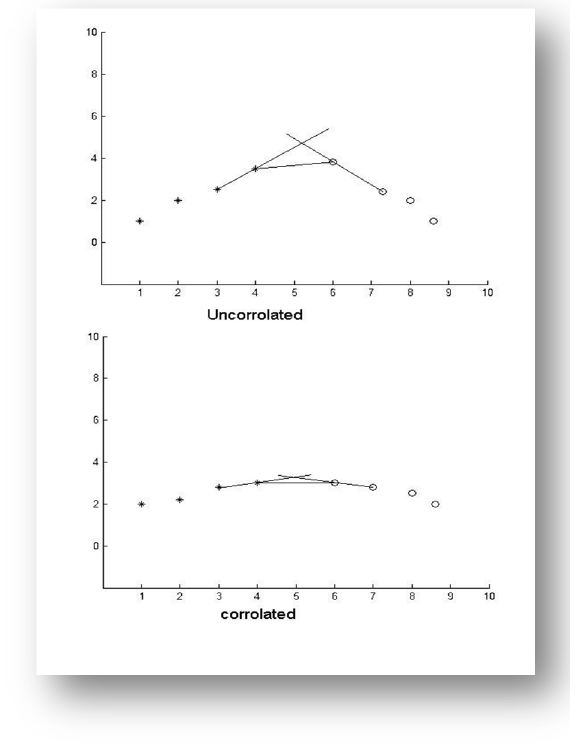
Figure 3. Correlation